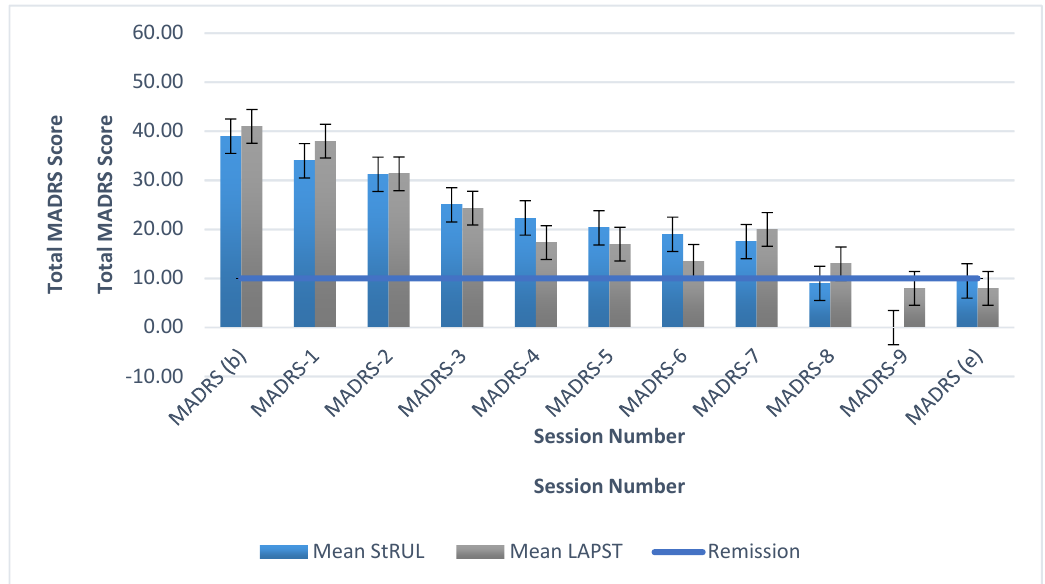
Figure 3. Means (SE) of MADRS scores for LAP-ST and UB-RUL ECT: Baseline MADRS score for